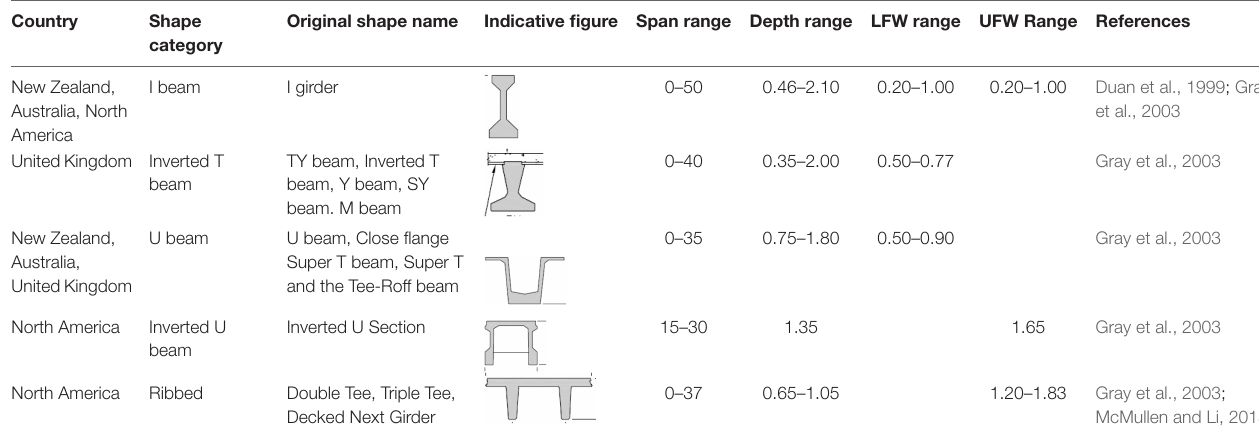
TABLE 2 | Standard beam shapes in different countries (all dimensions in